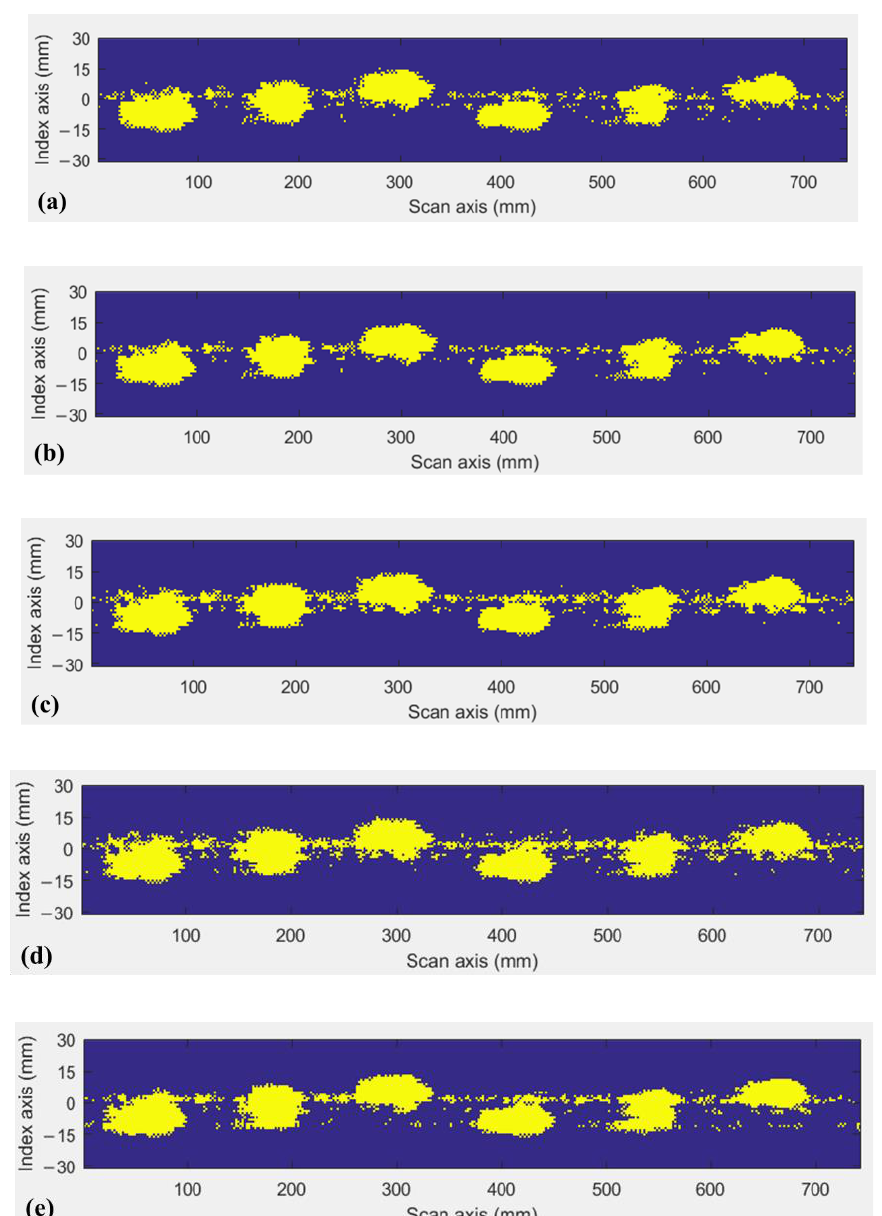
Figure 8. Processed C-scan images based on different classification results: ( a ) fusion; ( b ) automatic method; ( c ) time domain; ( d ) time-frequency domain; ( e ) frequency domain.